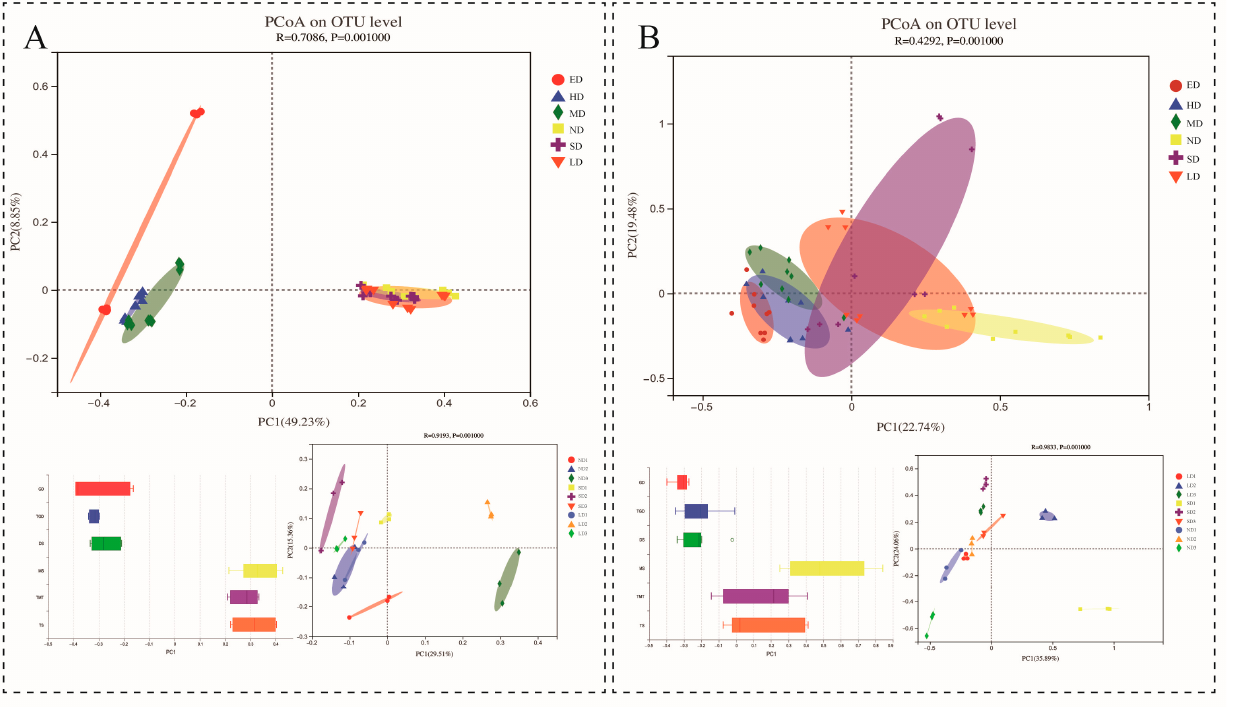
Figure 2. Principal coordinate analysis (PCoA) of bacterial ( A ) and fungal ( B ) communities at the OTU level based on weighted UniFrac distances. The lower right corners show the PCoA secondary grouping of the ND, SD and LD